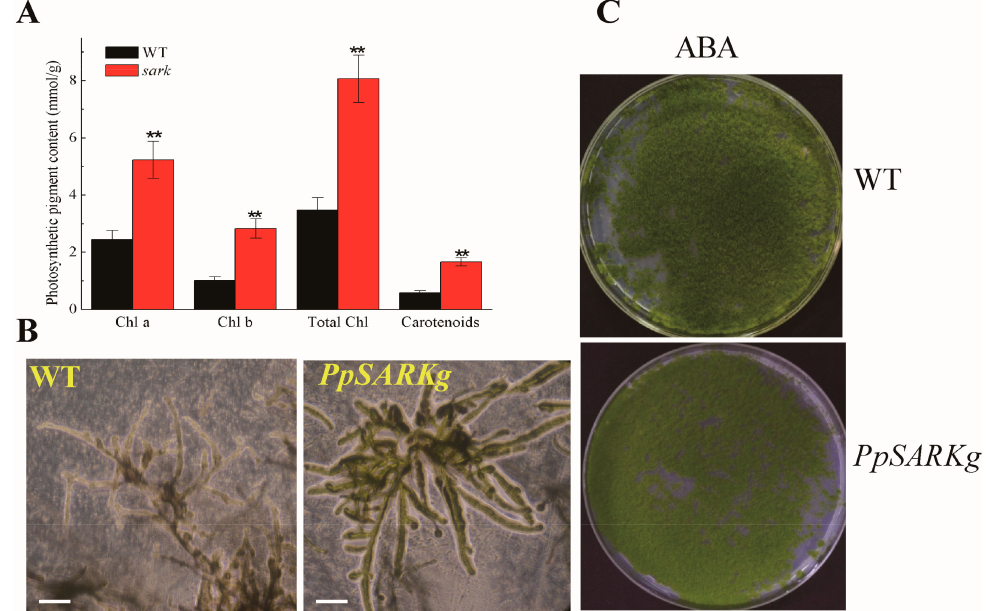
Figure 3. PpSARK regulated senescence in protonema tissues. ( A ) Pigments increased in the protonema of PpSARKg . Chl a—chlorophyll a; Chl b—chlorophyll b; Total Chl—Total chlorophyll. ( B ) Protonema of PpSARKg delayed senescence. ( C ) PpSARKg were not sensitive to extra ABA treatment. Data are represented as means ± SD, n = 3. The t -test was used and an asterisk indicates that the value of treatment is different from the control (WT); ** p < 0.01. The scale bar in ( B ) = 100